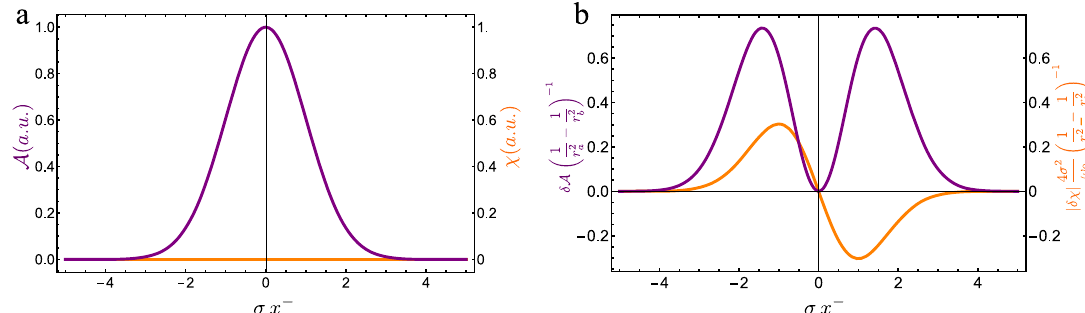
Fig. 3 Propagation of Gaussian wavepacket along radial direction in the Schwarzschild spacetime geometry. a Amplitude (purple) and phase (orange) of the initial Gaussian beam at the sender (Alice), respectively, presented by A ð a : u : Þ and χ ( a . u . ). Their units, a . u . , are chosen such that both are normalised to their maximum values. b The changes in the amplitude ( δ A ) and the phase ( δχ ) of the Gaussian wavepacket around frequency ω 0 with width of σ transmitted over the radial null geodesic in the Schwarzschild geometry between r a and r = r b , the geometry is shown in Fig. 2b. The units are chosen where the Schwarzschild radius and light speed are one.